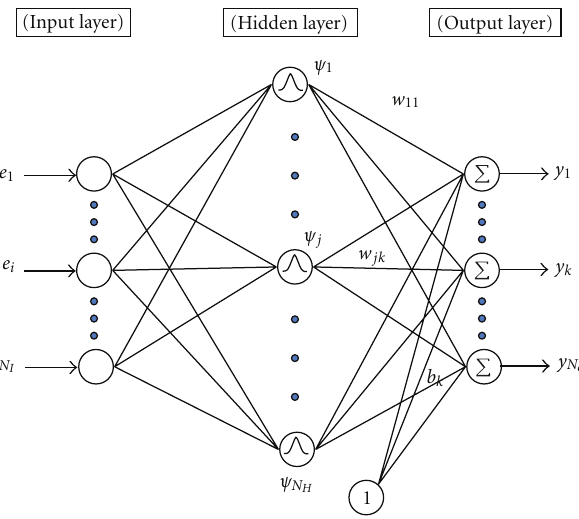
Figure 5: Neural network